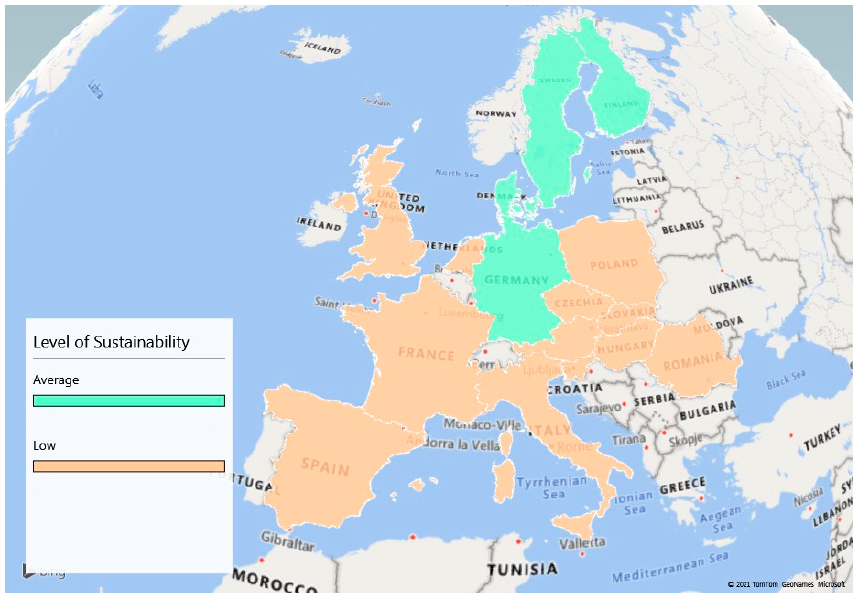
Figure 4. Map of countries based on sustainability level. Source: authors.